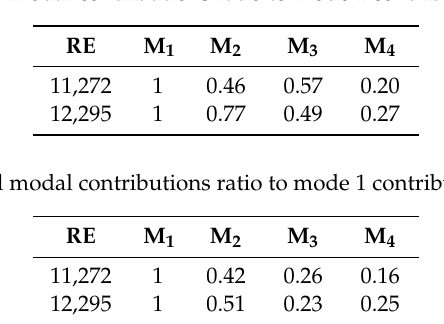
Table 4. Averaged modal contributions ratio to mode 1 contribution, L = 100 mm.